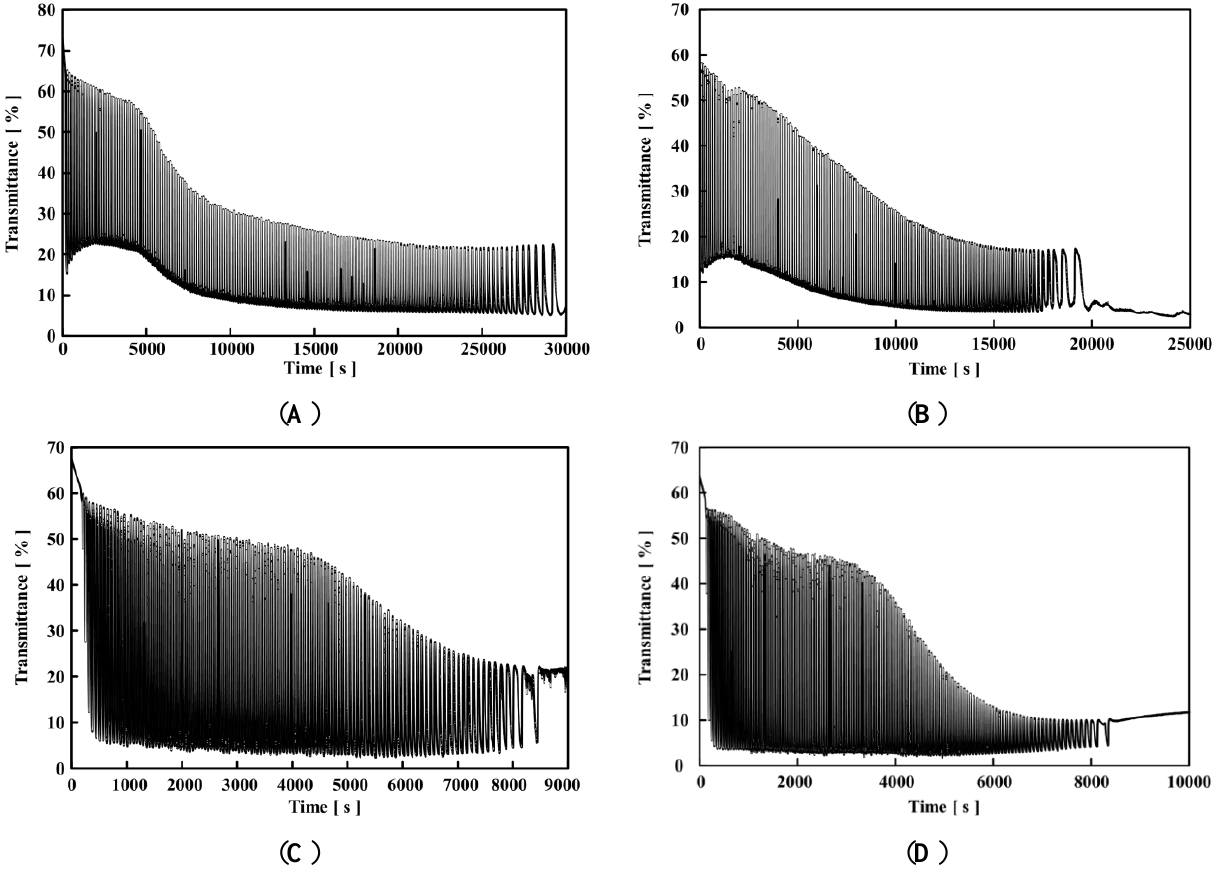
Figure 5. Oscillating profiles of transmittance at 18 °C for poly(NIPAAm- co -Ru(bpy) solutions with fixed HNO